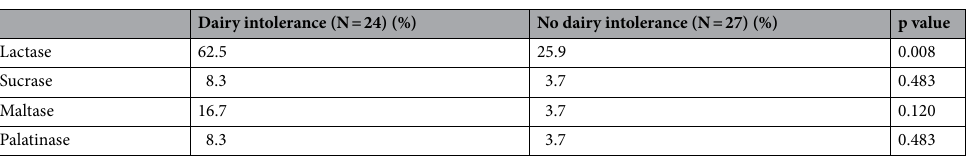
Table 2. Frequencies of disaccharidase deficiencies in abdominal pain program patients (for whom eating increases pain) reporting increased pain with dairy intake as compared to those not reporting increased pain with dairy